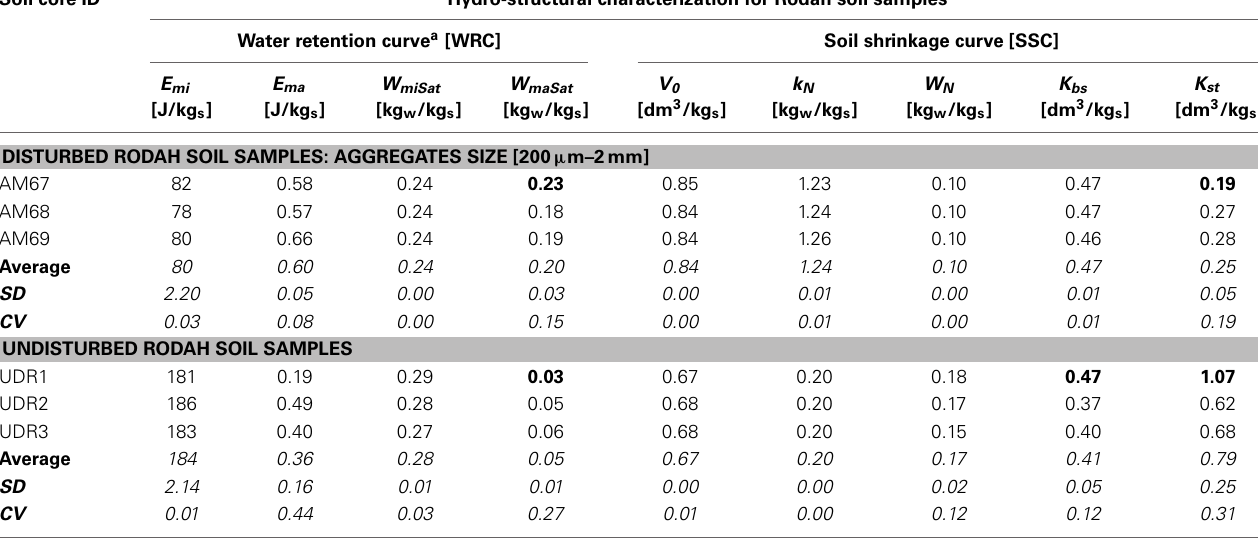
Table 3 | Hydro-structural parameters for the water retention curves and soil shrinkage curves of the reconstituted and undisturbed Rodah soil samples.